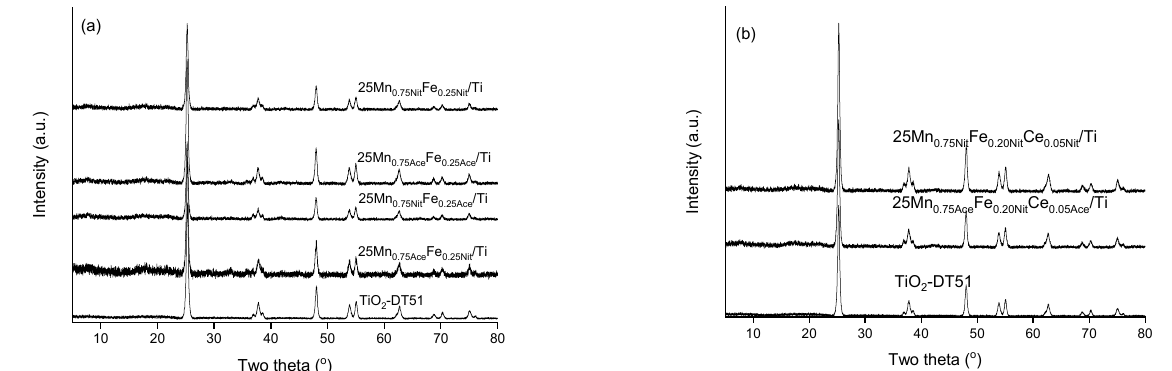
Figure 6. X-ray powder diffraction (XRPD) patterns of TiO 2 and the ( a ) 25MnFe/Ti and ( b ) 25MnFeCe/Ti catalysts. The XRPD patterns of the 5MnAce/Ti, 25Mn 0.75Ace Fe 0.25Nit /Ti, and 25Mn 0.75Ace Fe 0.20Nit Ce 0.05Ace /Ti samples calcined at several temperatures are shown in Figure 7. The 5MnAce/Ti catalyst showed similar diffraction patterns of anatase-TiO 2 at 400 ◦ C and there was a small deviation compared to the TiO 2 patterns at 500 ◦ C. With a further increase in temperature to 600 ◦ C, MnO 2 , Mn 2 O 3 , and anatase phases were observed. Similarly, the 25Mn 0.75Ace Fe 0.25Nit /Ti catalyst showed only anatase phases of TiO 2 at 400 and 500 ◦ C, and crystalline Mn 2 O 3 and anatase TiO 2 phases were observed at 600 ◦ C. No diffraction patterns of iron oxide were observed. Thus, we can clearly see that the presence of Fe can cause the transformation of the mixed manganese oxide phase into particles big enough for XRD detection to consist only of the Mn 2 O 3 phase. The 25Mn 0.75Ace Fe 0.20Nit Ce 0.05Ace /Ti catalyst showed only anatase TiO 2 phases even at 600 ◦ C, thus the combined presence of Fe and Ce on Mn/Ti can hamper the transformation of the amorphous to the crystalline phase.